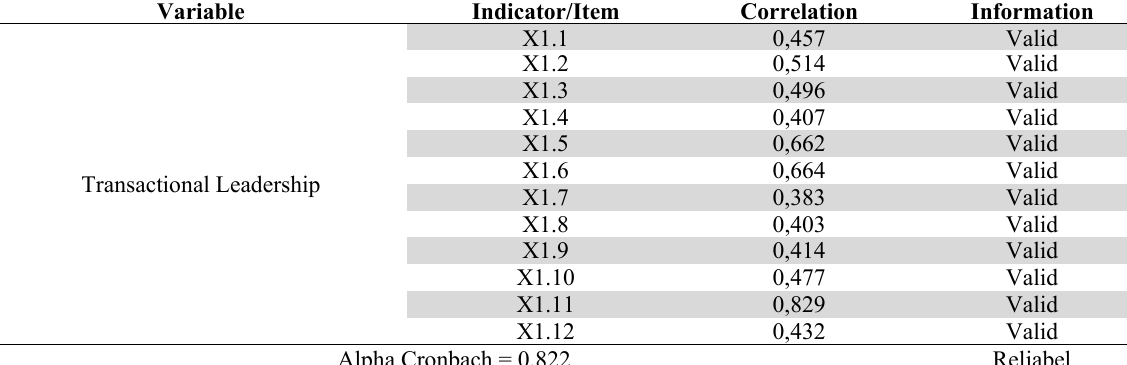
Validity and Reliability Test for Transactional Leadership Variable